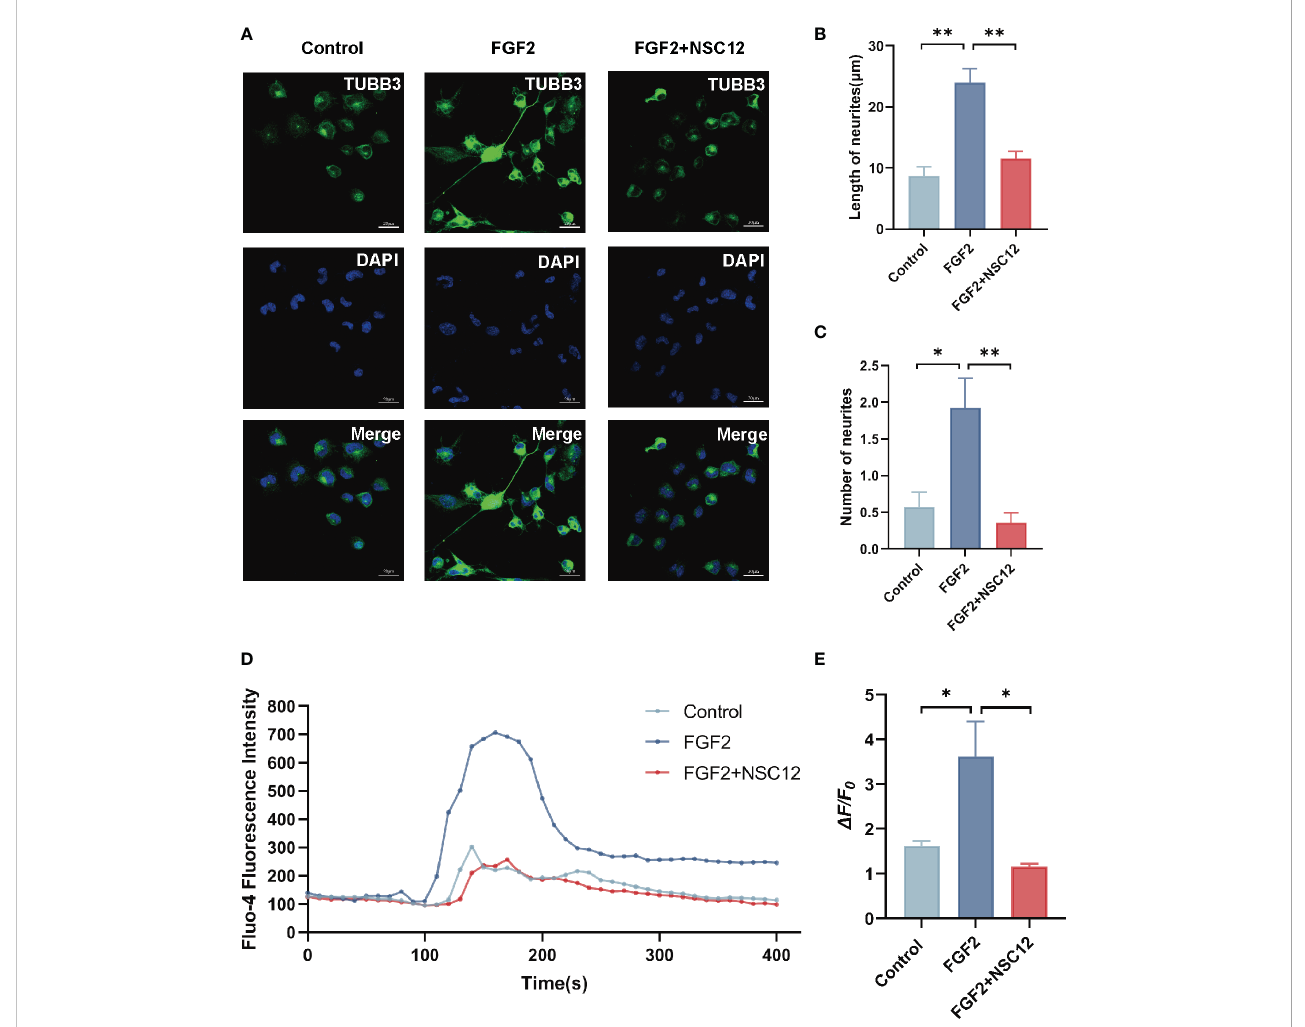
FIGURE 6 NSC12 could reverse the function of FGF2 in promoting neurite growth and Ca 2+ in fl ux in DRG cells. (A) Representative images of cell morphology and neurite growth in DRG cells treated by FGF2 (200 ng/mL) with or without preincubation of NSC12 (10 m mol/L). (B) Quanti fi ed results of length of neurites in different groups (n = 4, 5, 3). (C) Quanti fi ed results of number of neurites in different groups (n = 14, 14, 14). (D) Fluo-4 fl uorescence intensity of F11 cells treated by FGF2 with or without incubation of NSC12. (E) Ca 2+ peak increase ( D F/F0 ) in F11 cells treated by FGF2 with or without incubation of NSC12 (n = 3 in each group). * P < 0.05, ** P <